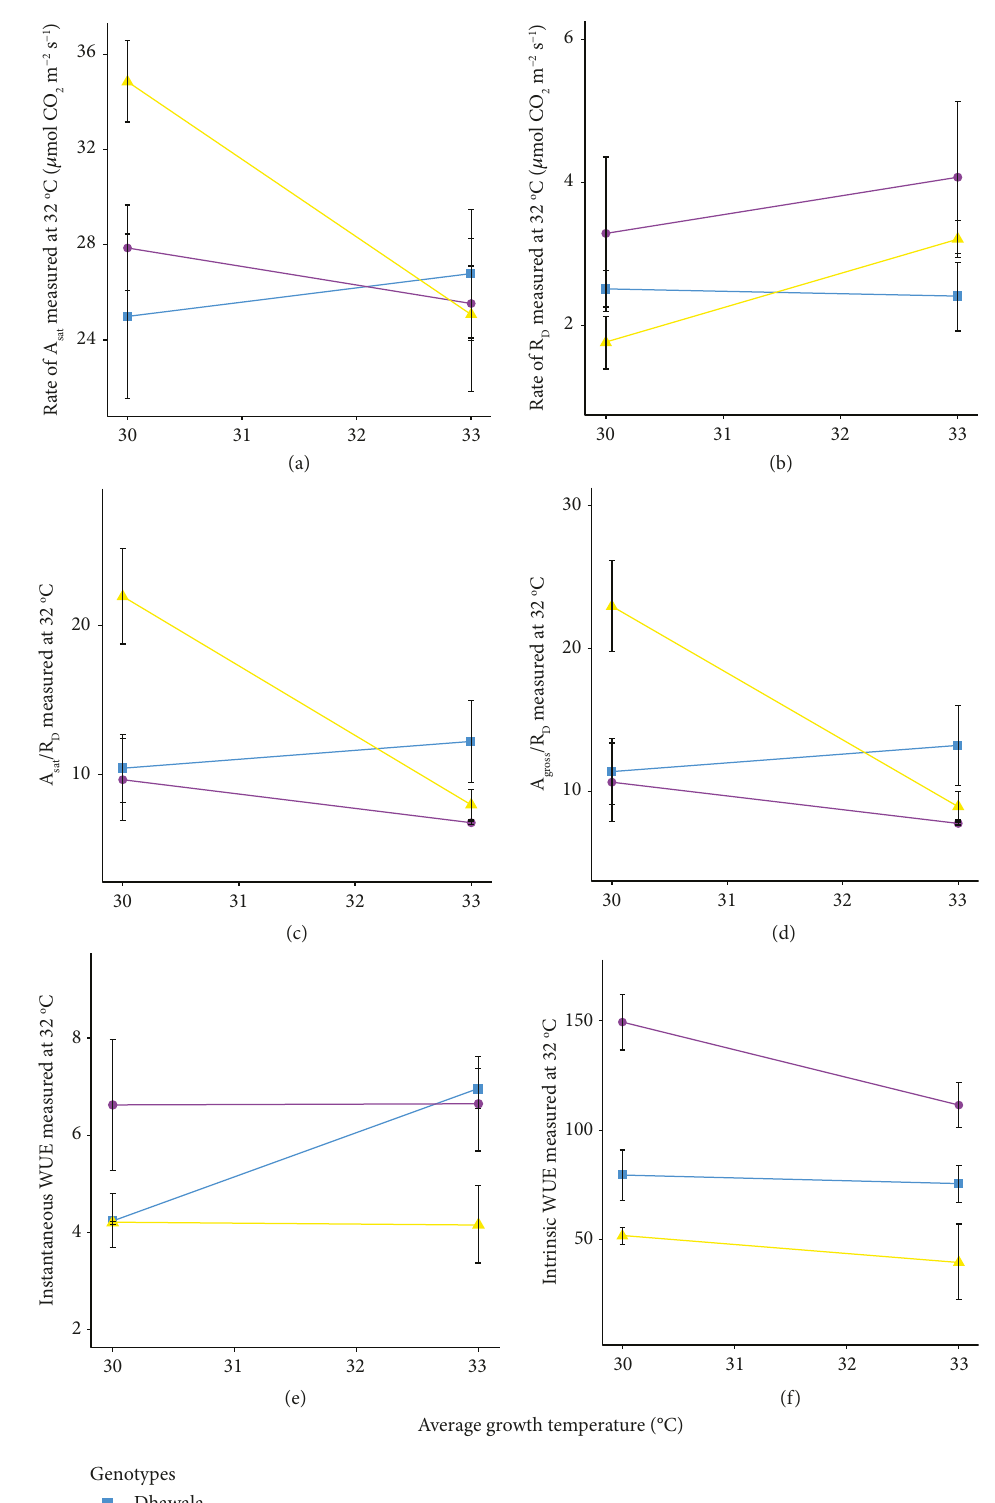
Figure 3: Leaf physiological traits of three cowpea genotypes grown at average daytime growth temperature, 30 ° C and 33 ° C, in Anuradhapura, Sri Lanka. (a) Light saturated net photosynthetic rate ( A sat ) at ambient level of CO 2 (400ppm) and photosynthetic photon flux density at 2200 μ mol · m − 2 · s − 1 measured at 32 ° C leaf temperature in two growth seasons, (b) rate of dark respiration ( R D ) measured at ambient level of CO 2 (400ppm) and at and 32 ° C measurement leaf temperature in two growth seasons, (c) ratio between A sat and R D at 32 ° C measurement leaf temperatureintwogrowthseasons,(d)ratiobetweengrossphotosyntheticrate( A gross )and R D at32 ° Cmeasurementleaftemperatureintwogrowth seasons, (e) ratio between A sat and transpiration rate at 32 ° C measurement leaf temperature in two seasons, and (f) ratio between A sat and stomatal conductance ( g s ) at 32 ° C measurement leaf temperature in two growth seasons. Whiskers around the points are the standard error of the